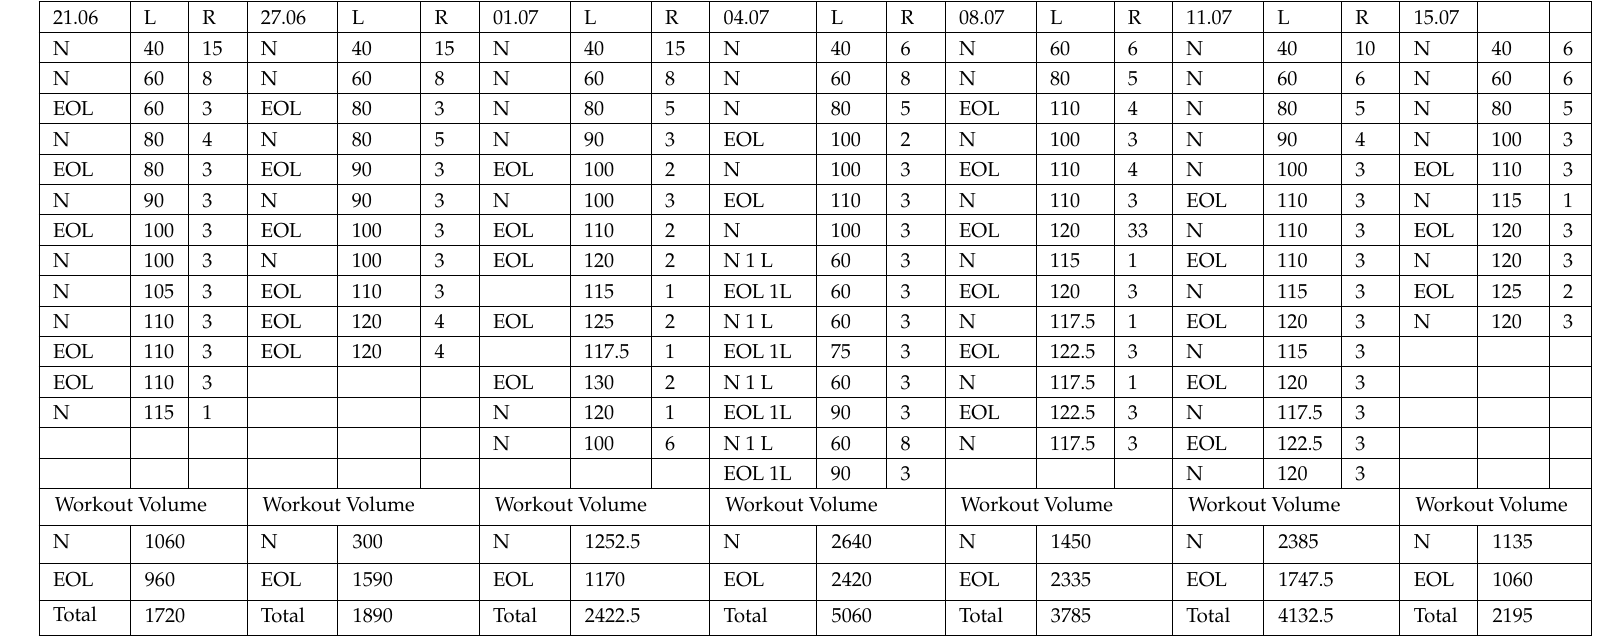
Table 2. Squat training sessions in the supramaximal eccentric training (SME) phase. Dates are day and month. L = load in kilograms, R = repetitions, N = normal squats, EOL = eccentric only loading, 1L = one-legged squats. Training volume was calculated as training load ×